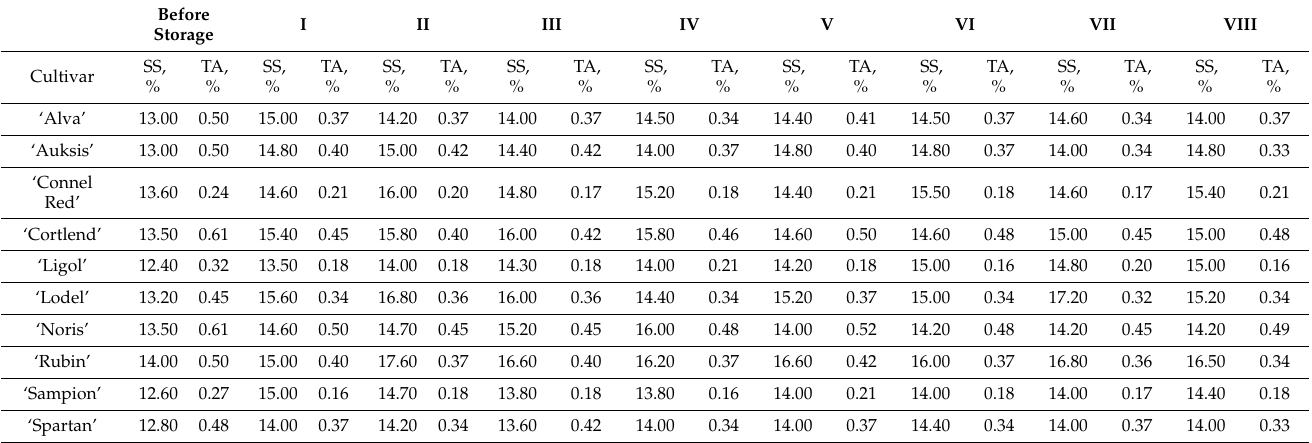
Table 4. Variability of the content of soluble solids and titratable acidity in apple samples before and after storage in CA. Before